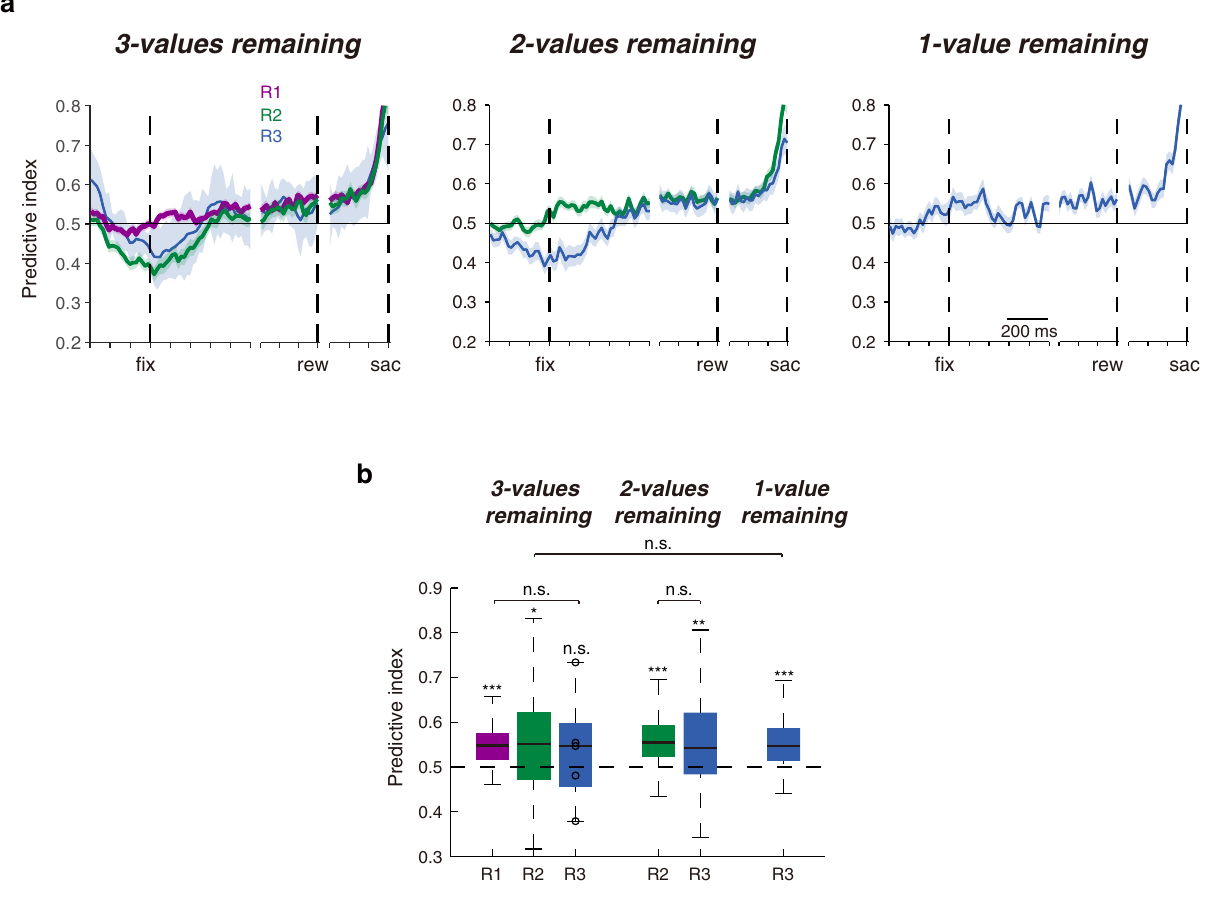
Fig. 6 Neuronal selectivity remained remarkably constant across conditions and menus. a The evolution of neuronal choice selectivity as determined by receiver-operating characteristic analysis when comparing choice-in activities of each value ranking with the highest available choice-out activity. All shaded regions represent SEM. b The average predictive indexes during the late fi xation period from ( a ). For conditions from left to right n = 49, 48, 5, 48, 38, and 33. n represents the number of blocks with at least fi ve cases for the condition. Data are presented for each value ranking when there were three values, two values, or one value ranking targets remaining in the array. For each value ranking, two-sided, one-way t test, from left to right, P = 4.8 × 10 − 8 , 0.040, 0.54, 7.2 × 10 − 8 , 0.0053, and 3.6 × 10 − 5 , respectively. N-way ANOVA tests, factor of value, P = 0.65, factor of menu, P = 0.36. Source data are provided as a Source data fi le. For the boxplots, on each box, the central mark is the median, the edges of the box are the 25th and 75th percentiles, and the whiskers extend to the most extreme data points that the algorithm considers not to be outliers. Outliers are data points that are larger than Q3 + 1.5